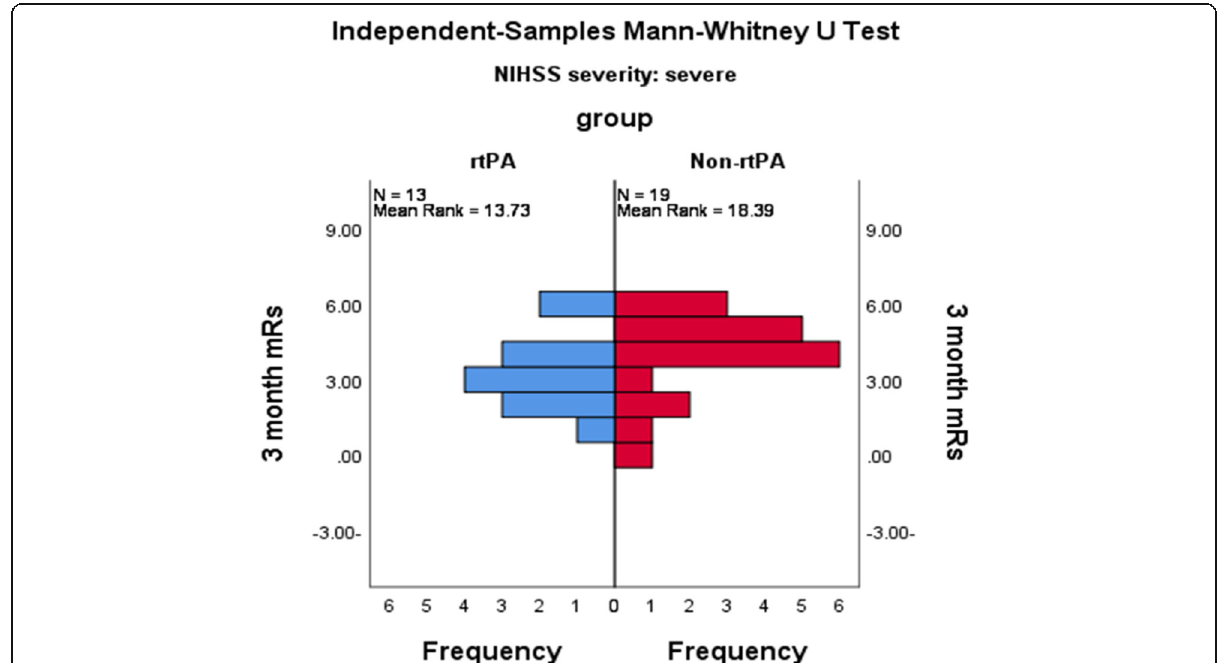
Fig. 3 Modified Rankin scale (mRs) at 3 months in severe stroke in both groups